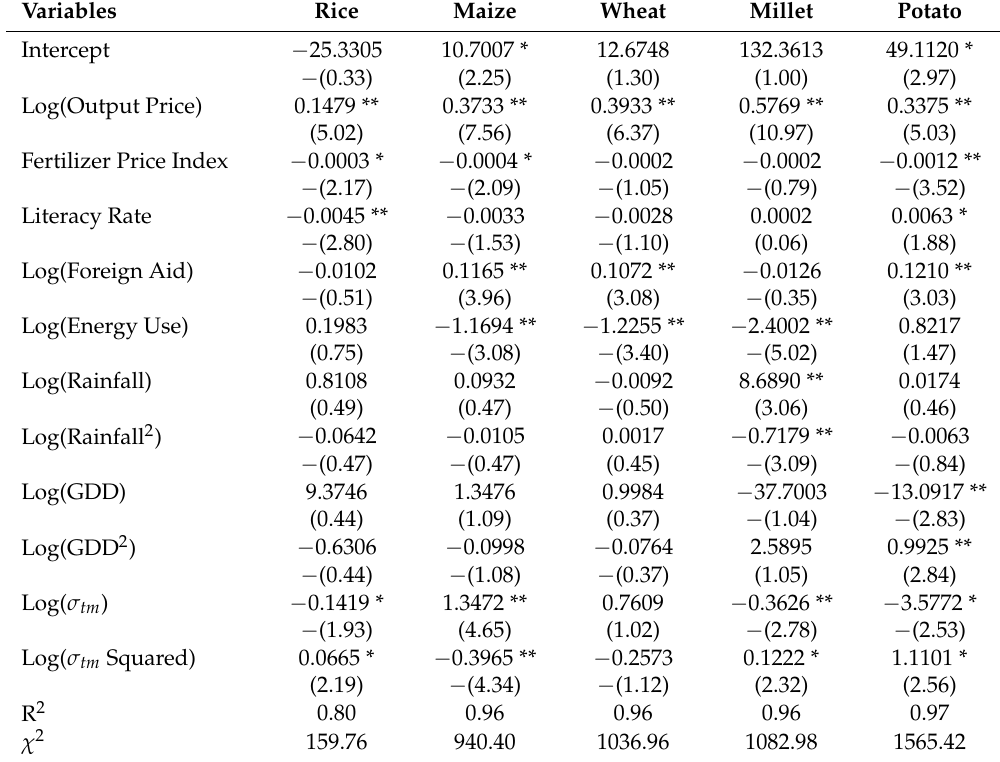
Table 3. Acreage Model